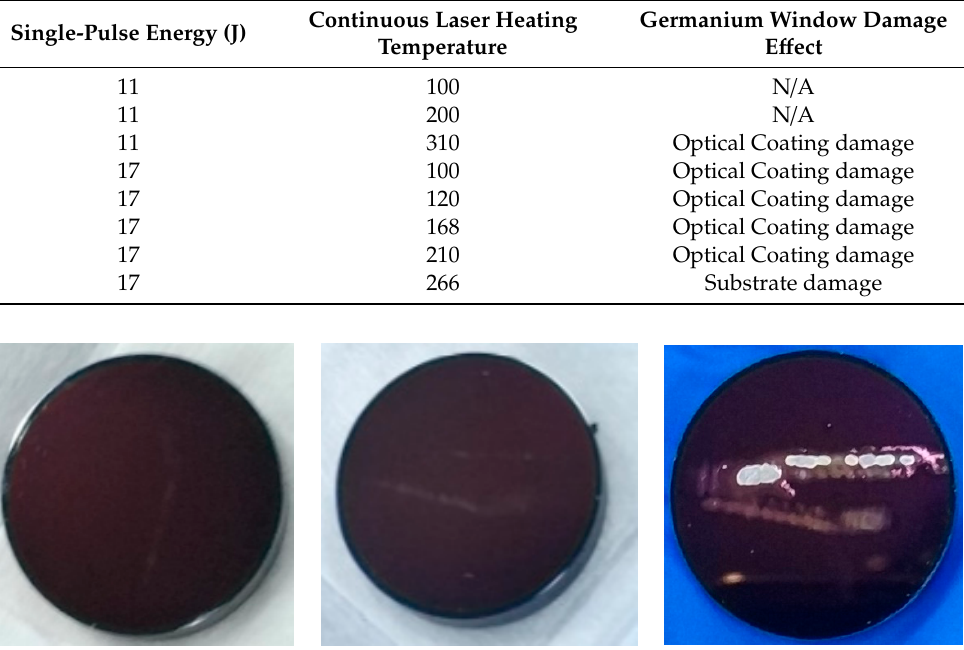
Table 10. Comparison of the damage thresholds of different lasers.